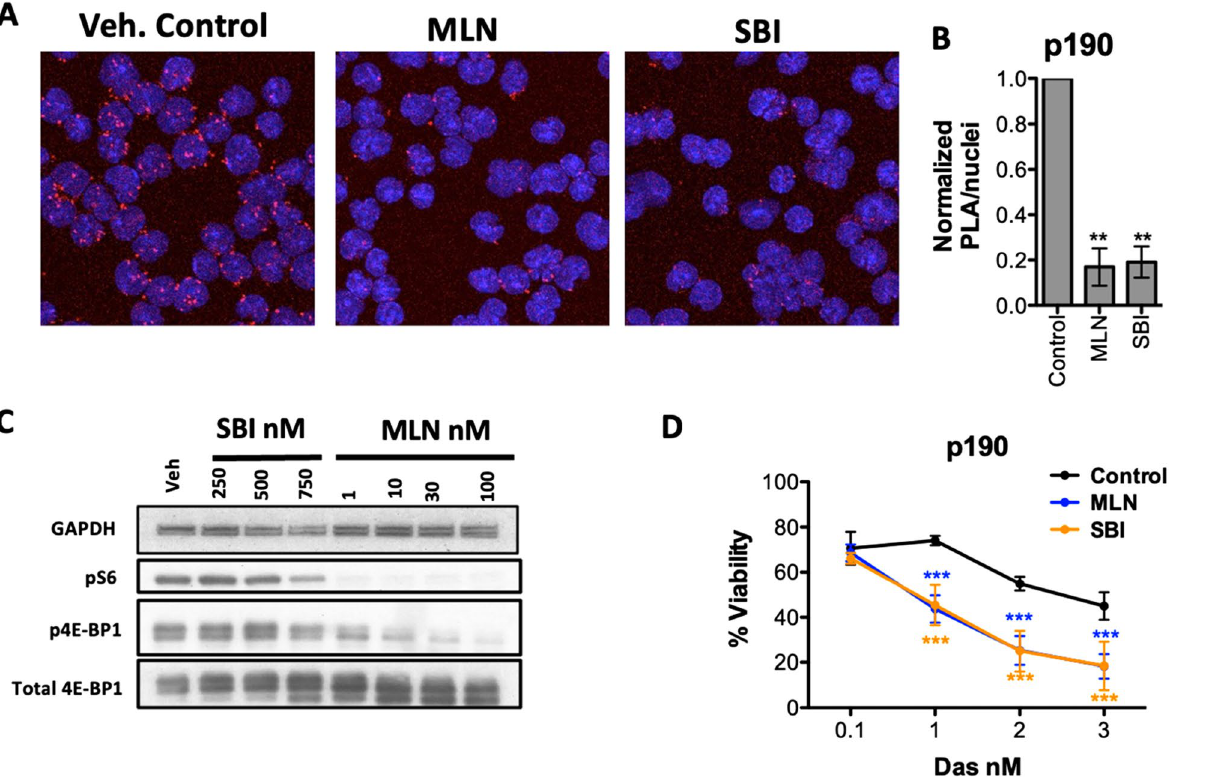
Figure 3. SBI-756 disrupts eIF4F and sensitizes to dasatinib without inhibiting mTORC1. ( A ) Proximity Ligation Assay (PLA) was done using p190 cells treated as indicated for 4 h and analyzed by confocal microscopy. Red dots indicate co-localization of eIF4E and eIF4G in situ. Blue = nuclei stained with DAPI. ( B ) Quantitation of PLA data normalized to the number of nuclei (5 fields, 3 replicates). A one-sample t test was done to show that treatment is significantly different from normalized control. ** p < 0.01, n = 3. ( C ) Western blot of p190 cells treated with SBI-756 or MLN0128 at the indicated concentrations for 4 h. ( D ) Viability assay of p190 cells treated as indicated for 48 h. Significance was calculated using two-way ANOVA (*** p < 0.001, n = 3). ( A , B , D ) MLN0128 was used at 100 nM, and SBI-756 at 500